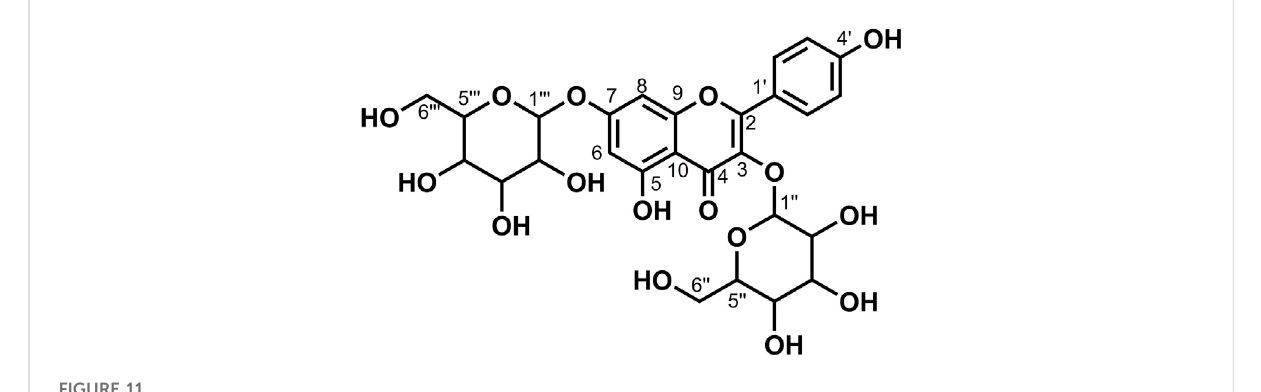
FIGURE 11 Chemical structure of compound 15